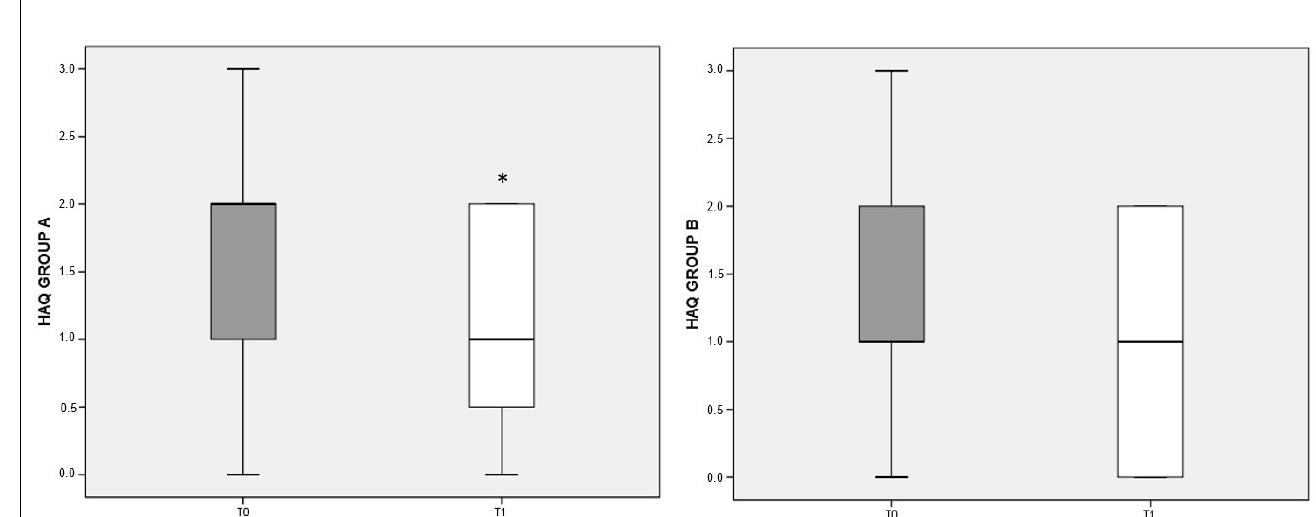
Figure 4. HAQ variation referred to different dietary regimens. Box plots graphically depict the median and interquartile range of HAQ score in groups A and B. p -value derived from Wilcoxon matched-pairs signed rank test; * p < 0.05 T1 HAQ vs. T0 HAQ.